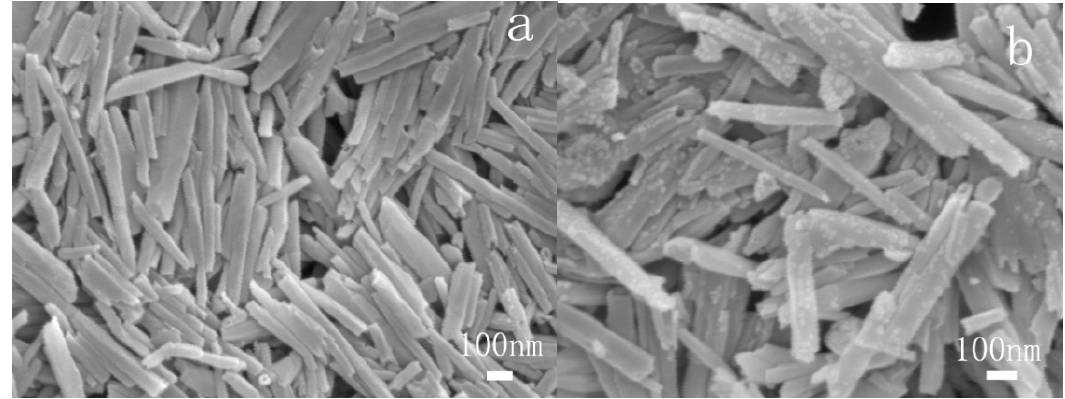
Figure 4. SEM images of HNTs ( a ) and m-HNTs ( b ).